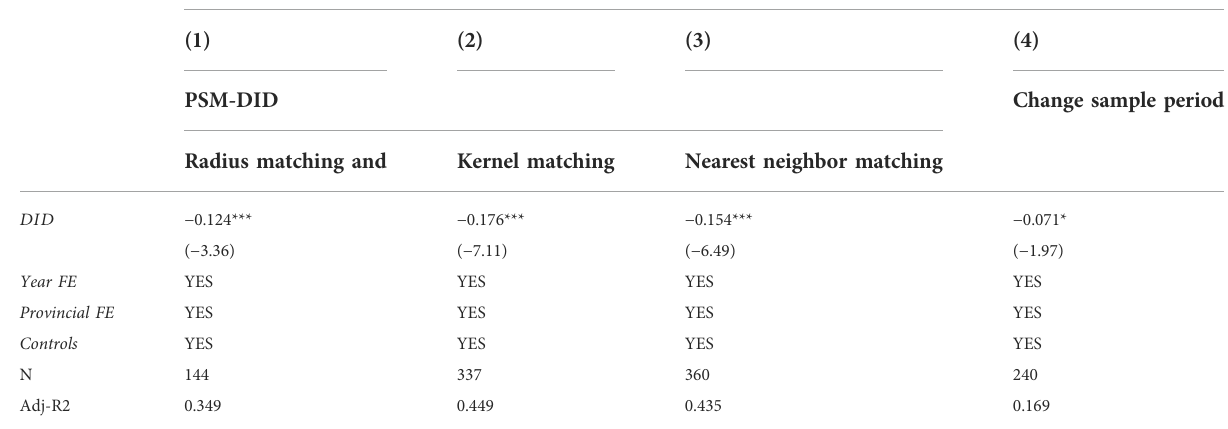
TABLE 4 Robustness test.